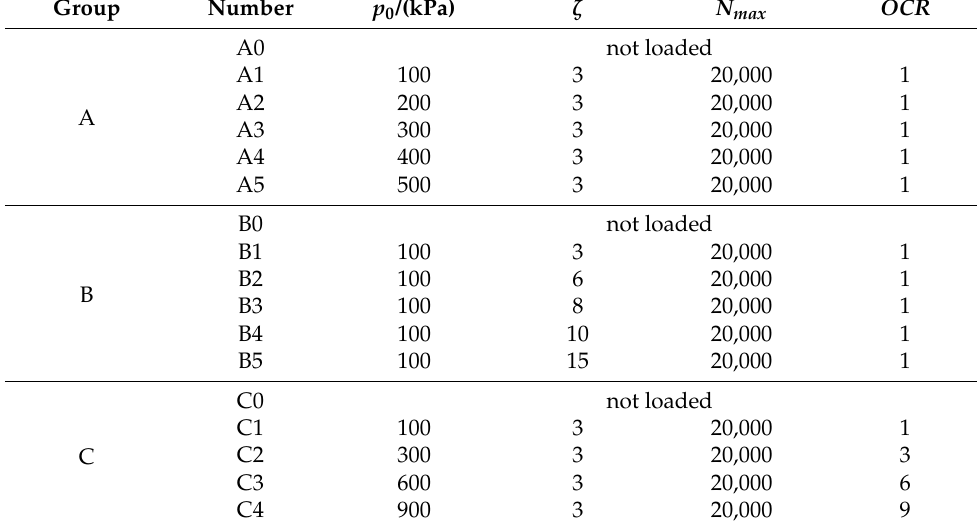
Table 2. Experimental